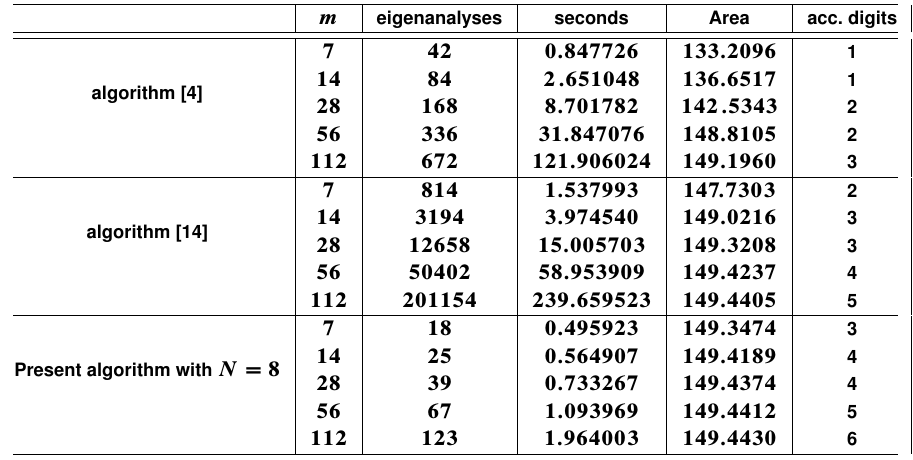
Table 1. Performance of algorithms from [14], [4] and the present one, for the matrix of the Example 5.1. The area is computed between the vertical lines x D (cid:0) 6 and x D 6 , for z D x C iy .